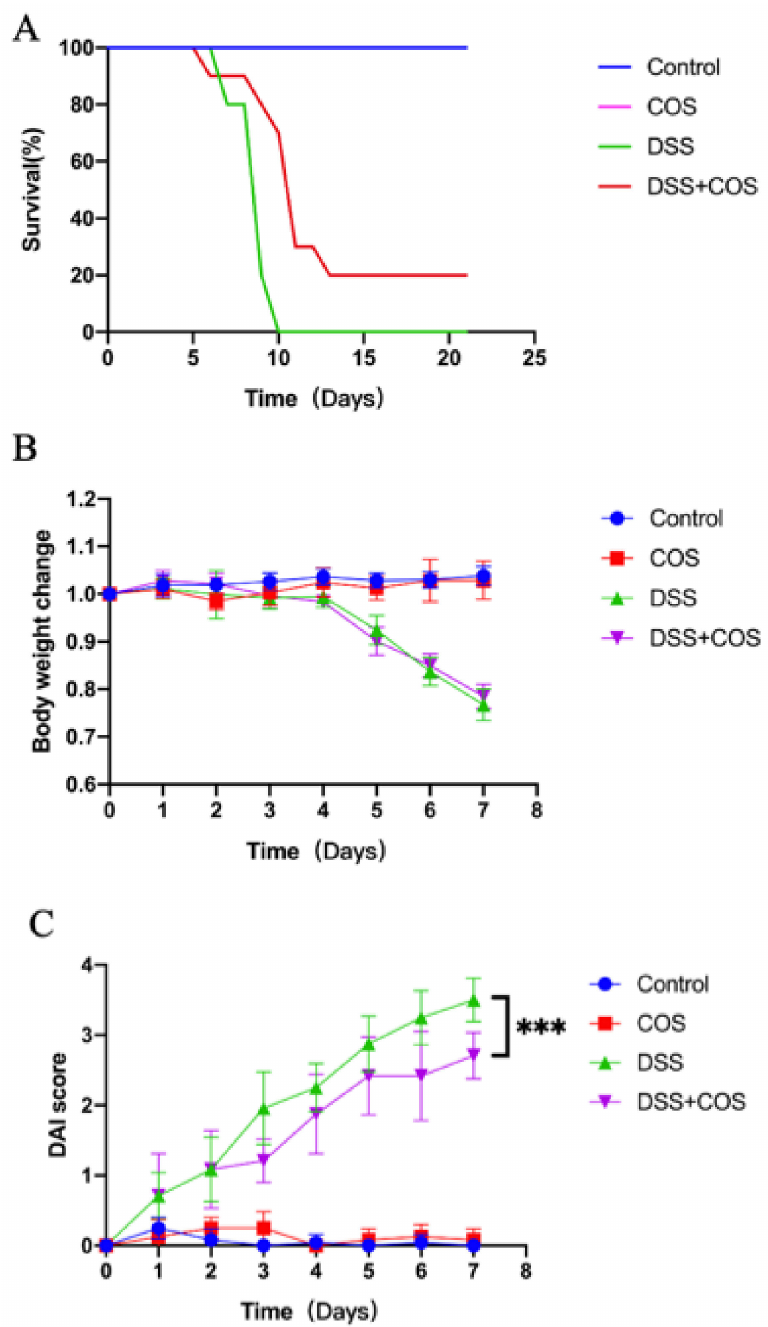
Figure 5. Treatment with COS improved clinical symptoms of DSS-induced colitis. Mice were given 4% (wt/vol) of DSS in drinking water for 7 consecutive days and intraperitoneally injected with COS at a dose of 200 mg/kg/day for 21 days at the same time. ( A ) Effect of treatment with COS on the survival rate of mice at 21 days. ( B ) Effect of treatment with COS on the body weight change of mice at 7 days. ( C ) Effect of treatment with COS on the DAI score of mice at 7 days. Results were presented as mean ± SD ( n = 8; ns, not significant, *** p <